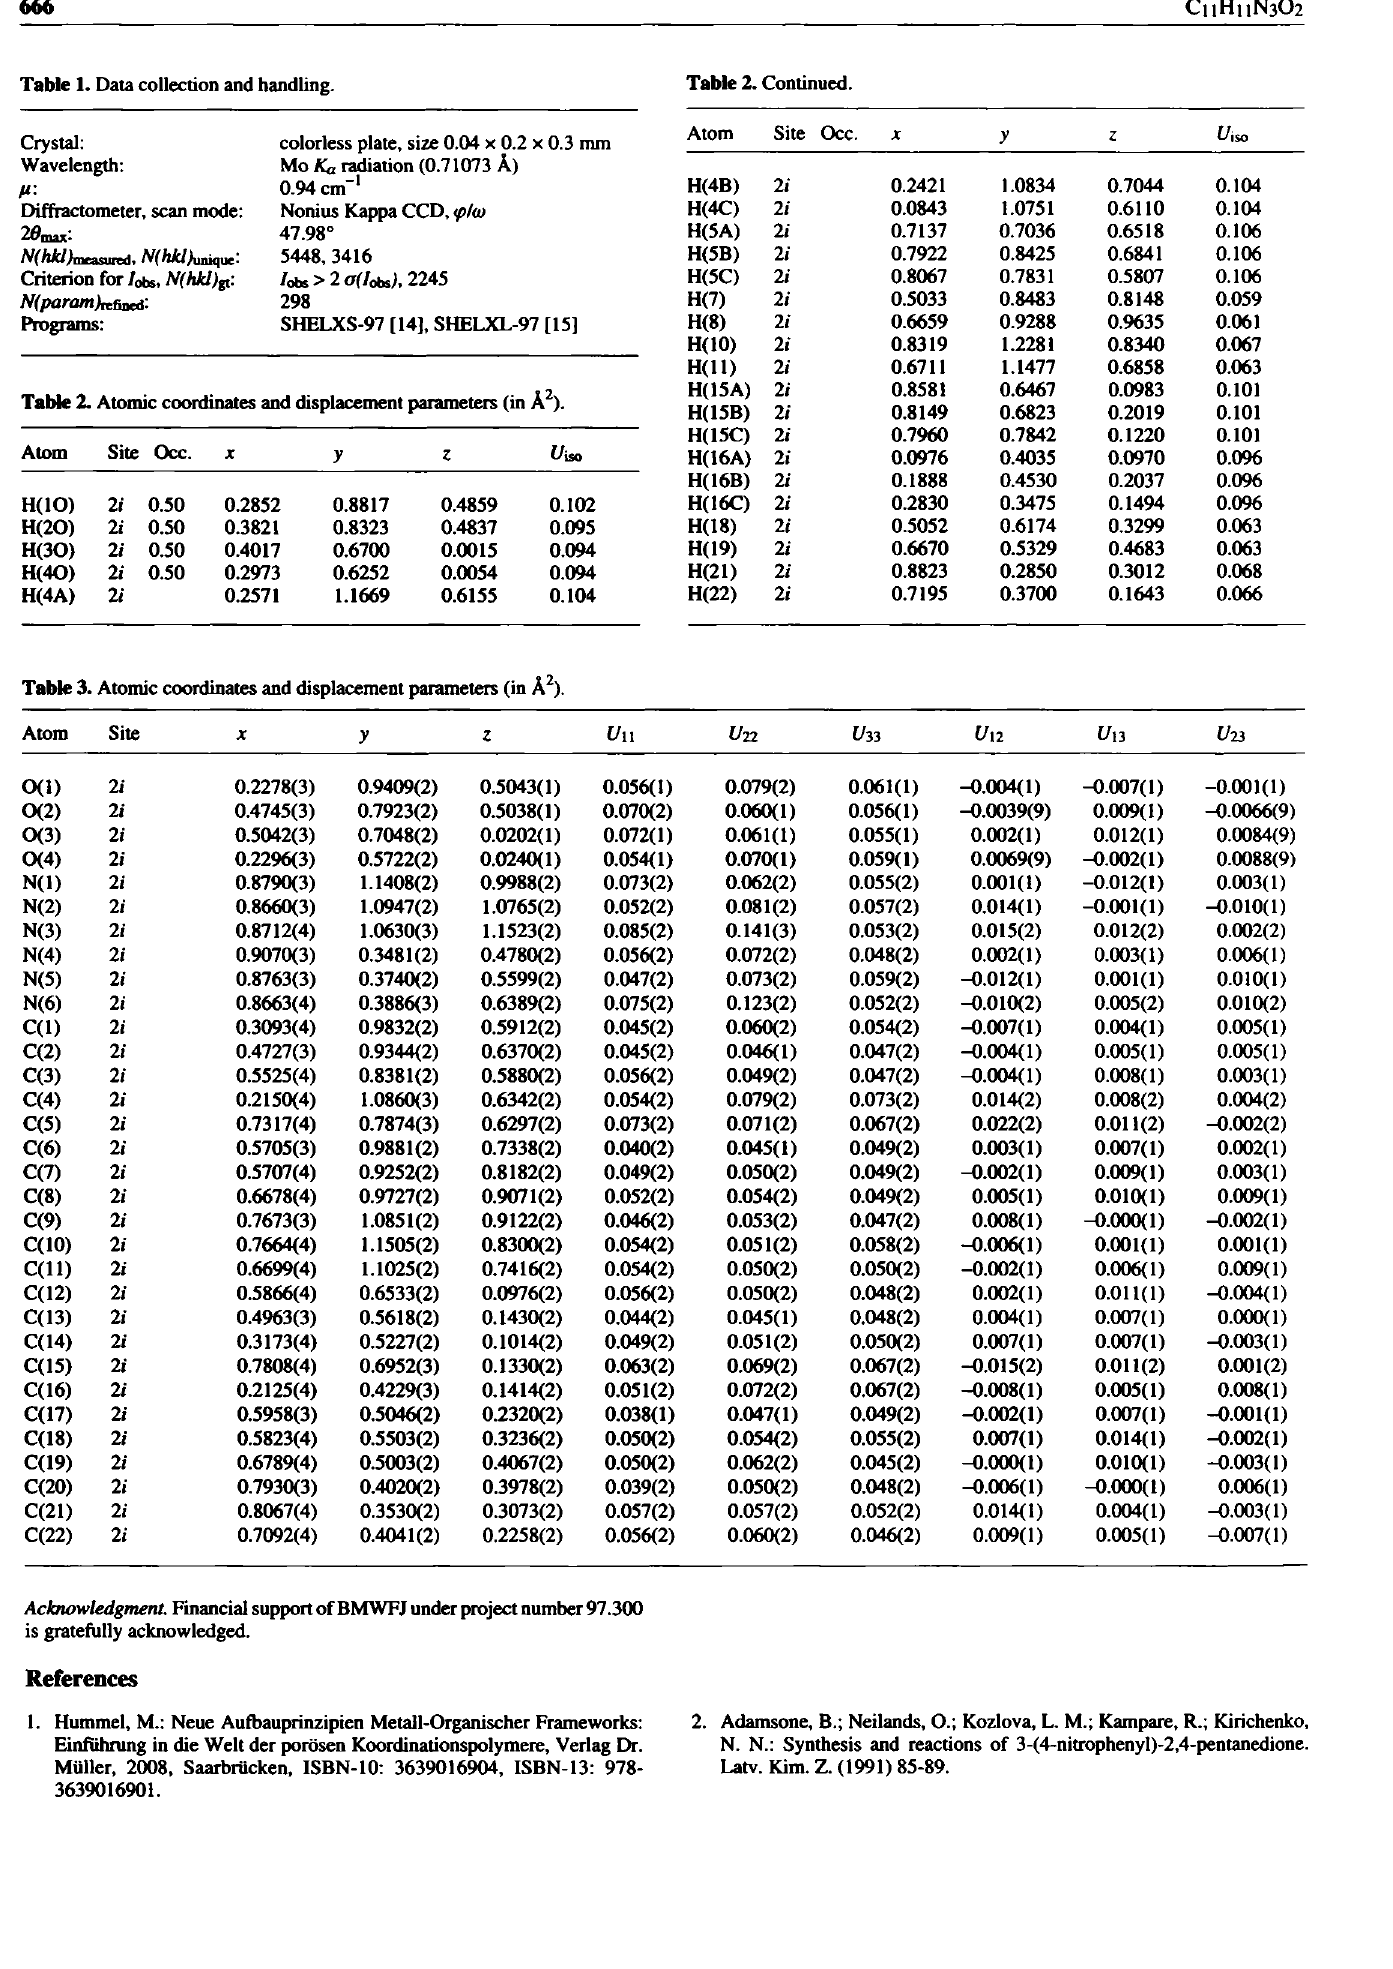
Table 2. Atomic coordinates and displacement parameters (in Â 2 ).